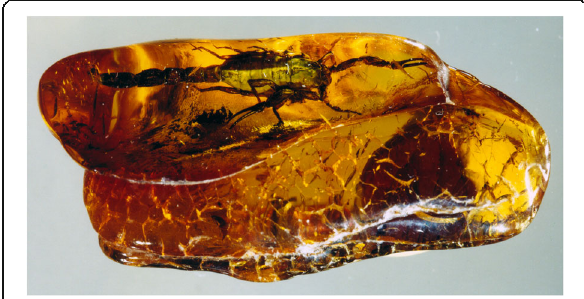
Fig. 9 Palaeoananteris ribnitiodamgartensis Lourenço & Weitschat (Buthidae). Adult male from Early-Cenozoic Baltic amber